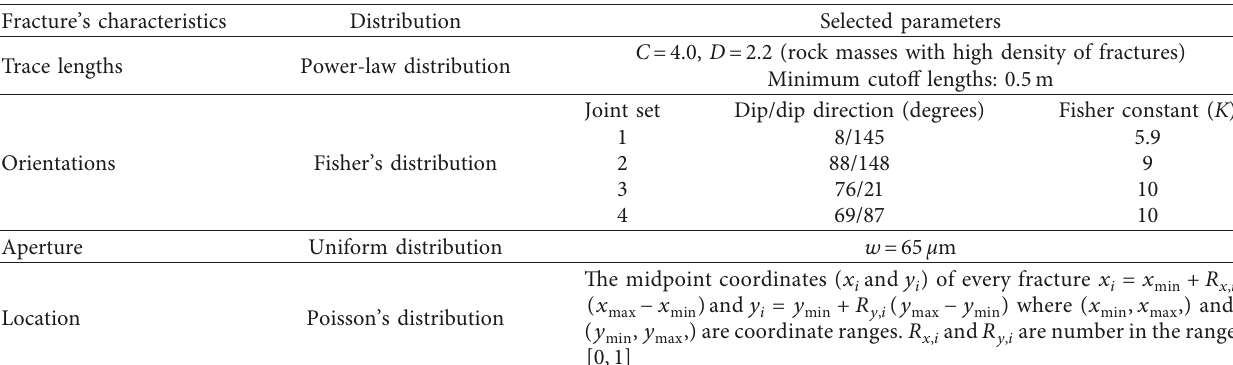
Table 1: Selected parameters for the generation of the fractures network in the Sellafield fractured rock mass. Fracture’s characteristics Distribution Selected parameters